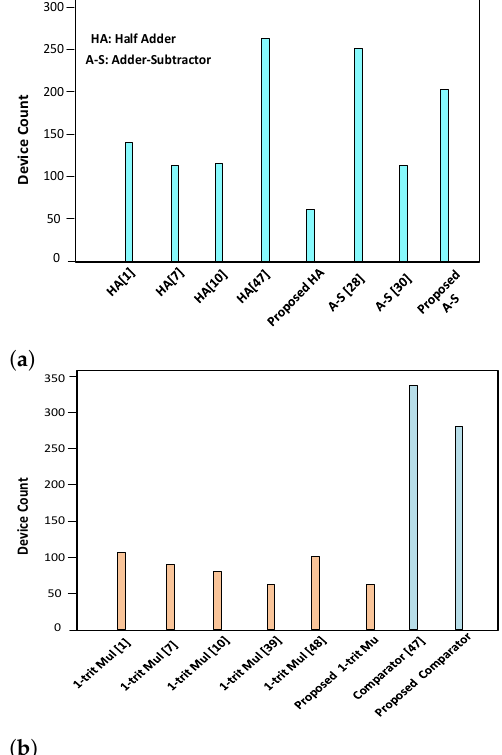
Figure 19. Device count comparison of arithmetic modules. ( a ) Adder designs, ( b ) multiplier and comparator